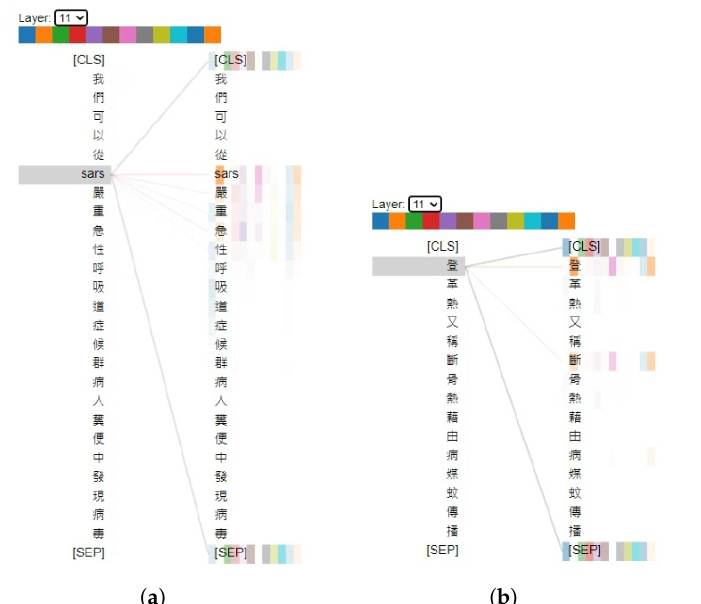
Figure 5. Visualization of semantics capturing: ( a ) we can find the virus in the feces of SARS 嚴 重 急 性 呼吸 道 症 候 群 (SARS in the Chinese language) patients; and ( b ) dengue fever is also known as 斷 骨 熱 (another Chinese name for dengue fever) which is transmitted by vector mosquitoes.